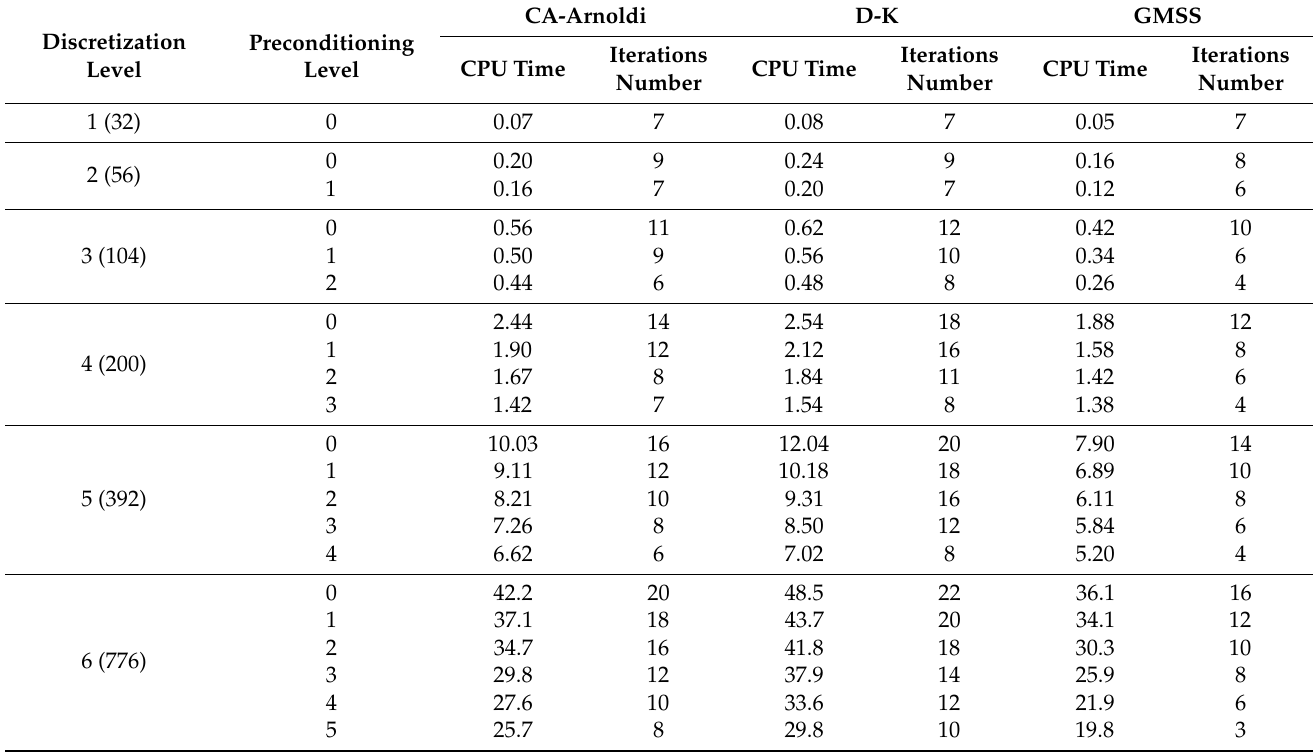
Table 2 contrasts the computing resources for modeling nonlinear fractional bio- thermomechanical problems in FGA viscoelastic soft tissues using the generalized finite difference method (GFDM) of Turchan [45], the finite element method (FEM) of Marin et al. [46], and the boundary element method (BEM). The effectiveness of our suggested BEM method is displayed in the Table